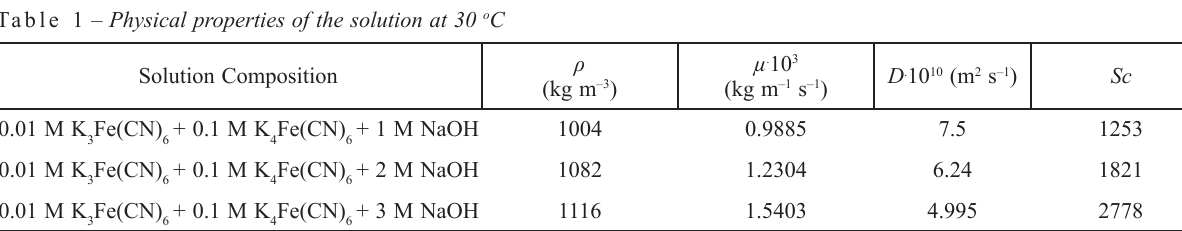
Table 1 – Physical properties of the solution at 30 o C Solution Composition